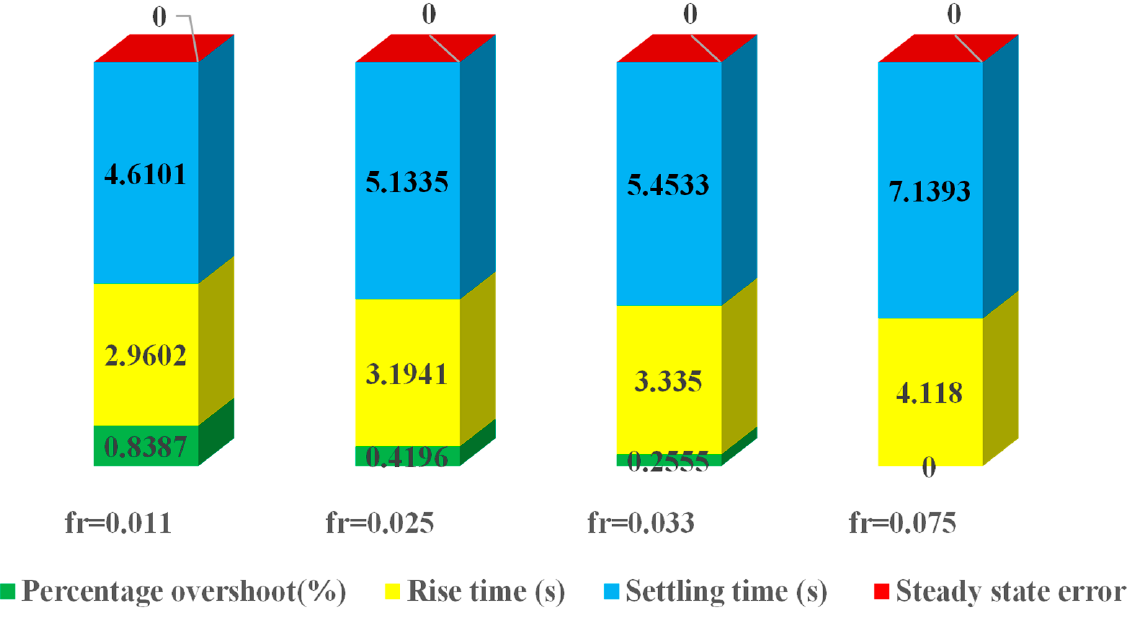
Figure 41. Wind variation effect on BEV